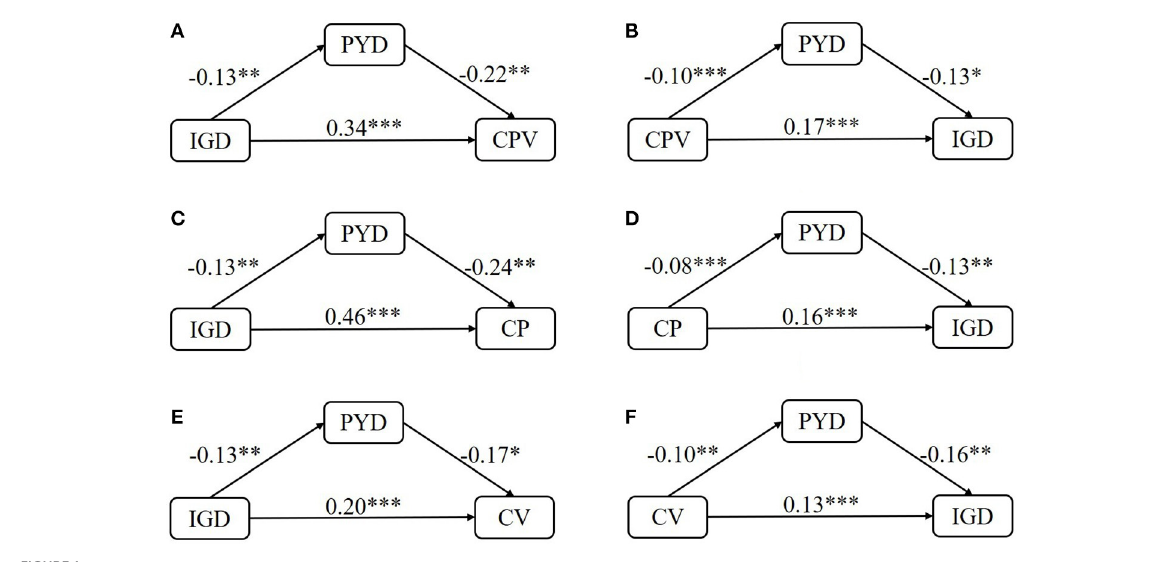
FIGURE1 Test of the mediating effects of PYD attributes [Model (A–F) ]. PYD, positive youth development attributes; IGD, internet gaming disorder; CPV, total cyberbullying involvement; CV, cyberbullying victimization; CP, cyberbullying perpetration. Standardized coefficients were reported. * p